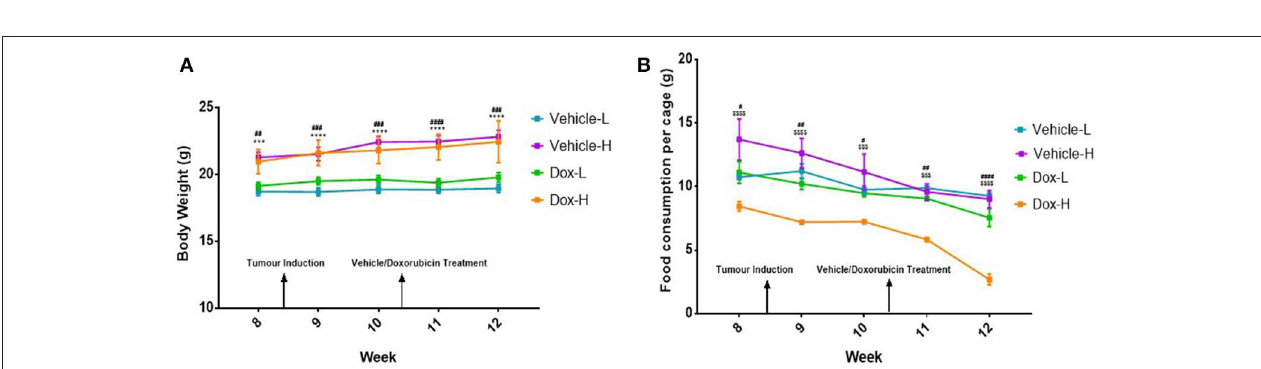
FIGURE 3 | (A) Mean body weight, and (B) food consumption of mice ( n = 5 per cage) receiving vehicle-or doxorubicin treatment while on the LFD control compared to the HFD. Results are presented as mean ± SEM ( n = 10 per group). Three-way ANOVA with Fisher’s LSD post hoc correction was applied and p < 0.05 was considered as statistically significant. *** p < 0.001 and **** p < 0.0001. # p < 0.05, ## p < 0.01, #### p < 0.0001, $$$ p < 0.001 and $$$$ p < 0.0001. *Vehicle-L vs. Vehicle-H, # Dox-L vs. Dox-H, and $ Vehicle-H vs. Dox-H.